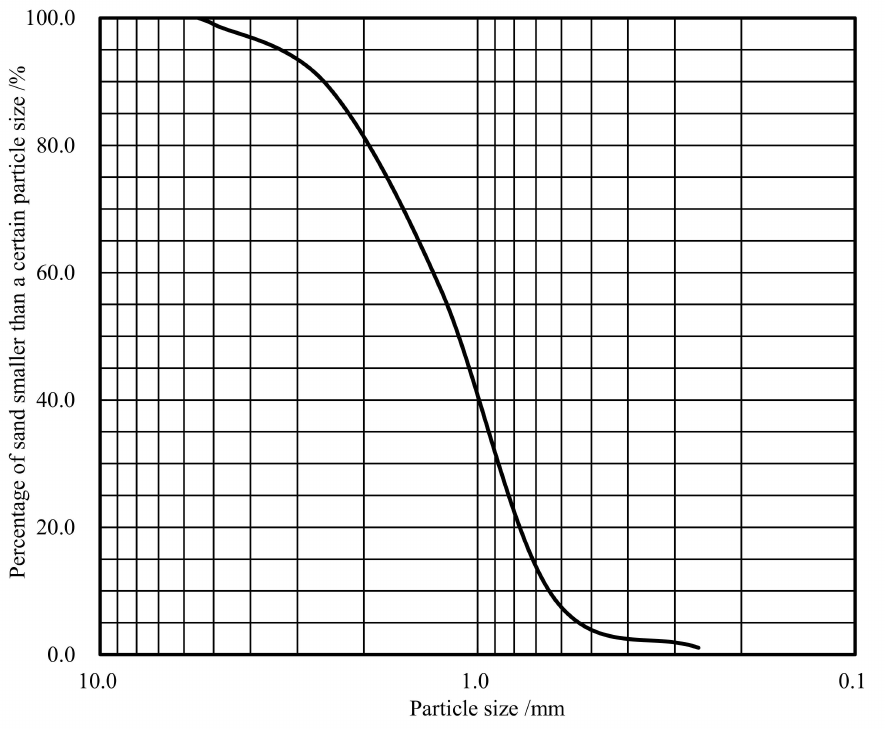
Figure 2. Grain size distribution of the sand used in this study. Energies 2020 , 13 , x FOR PEER REVIEW